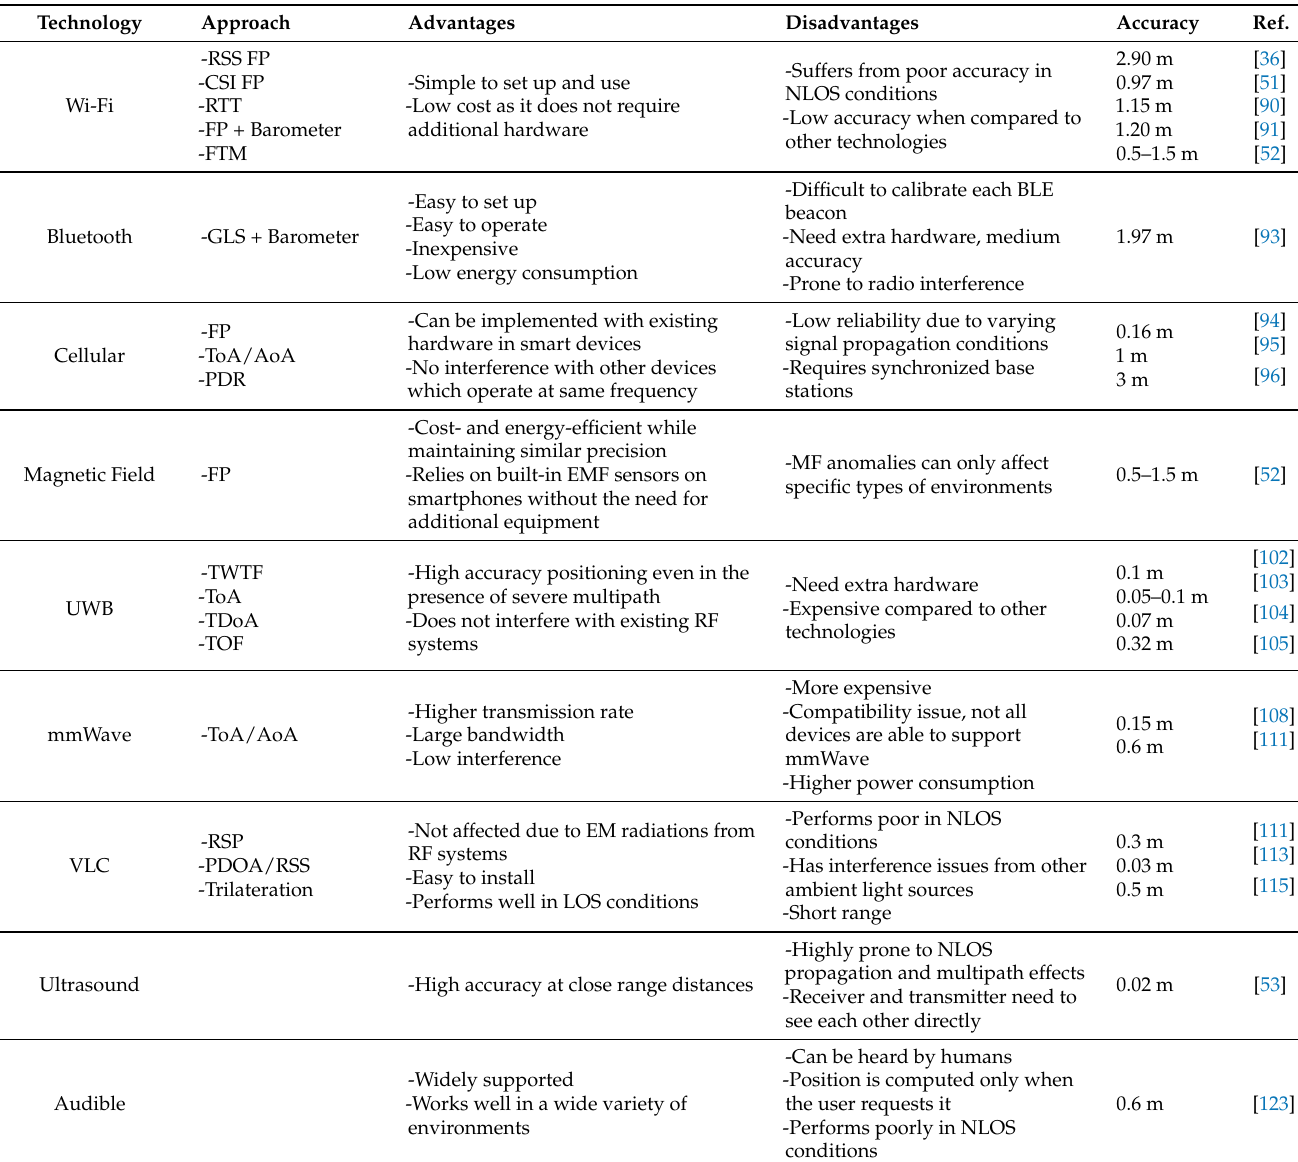
Table 6. Comparison of 3D Indoor Positioning